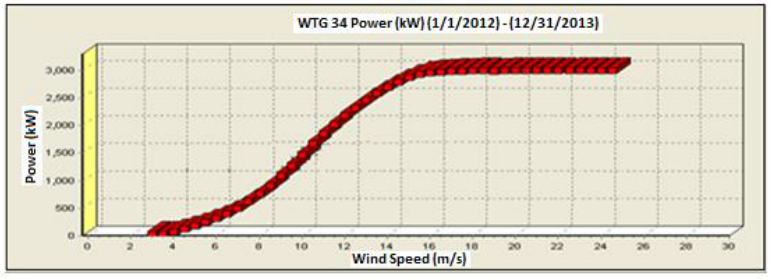
Figure 3. WTG34 power